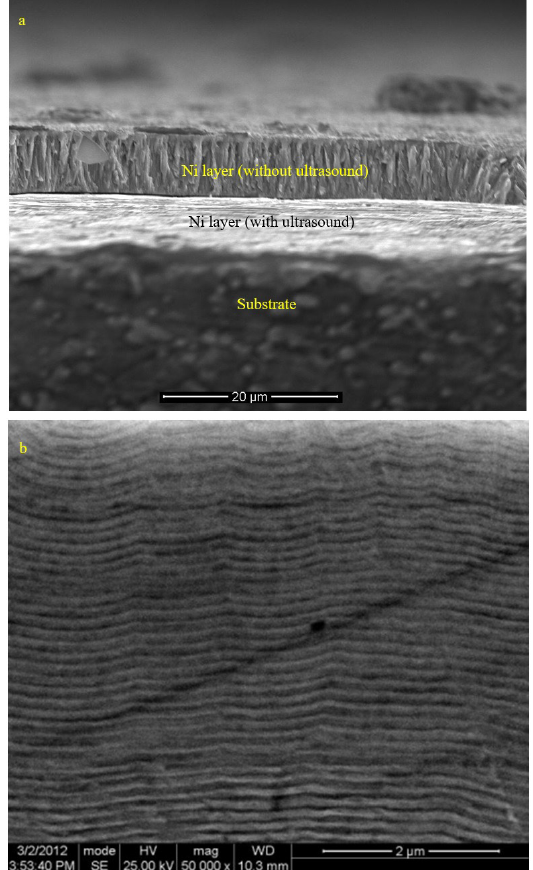
Figure 2. SEM images of the cross section of Ni coatings. (a) bilayered Ni coating (b) multilayered Ni